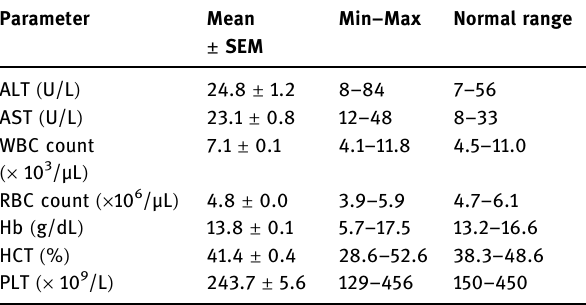
Table 1: Biochemical parameters of dental